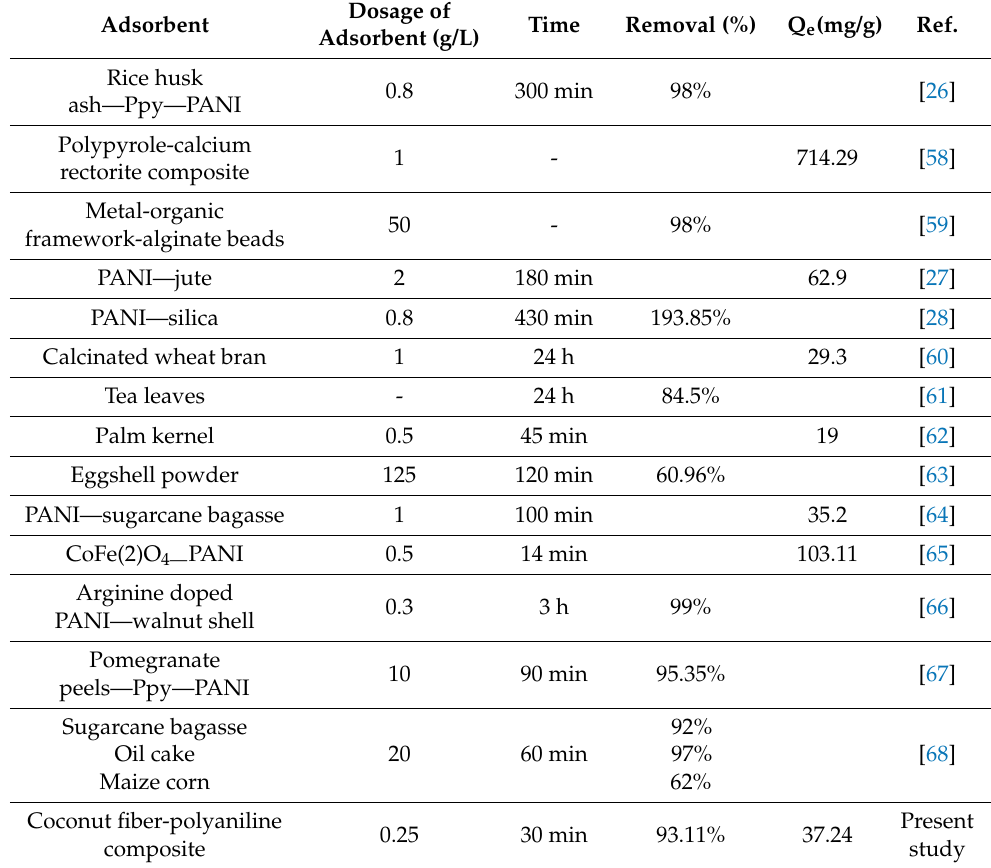
Table 5. Summary of research papers on the removal of chromium using PANI and bio-waste based